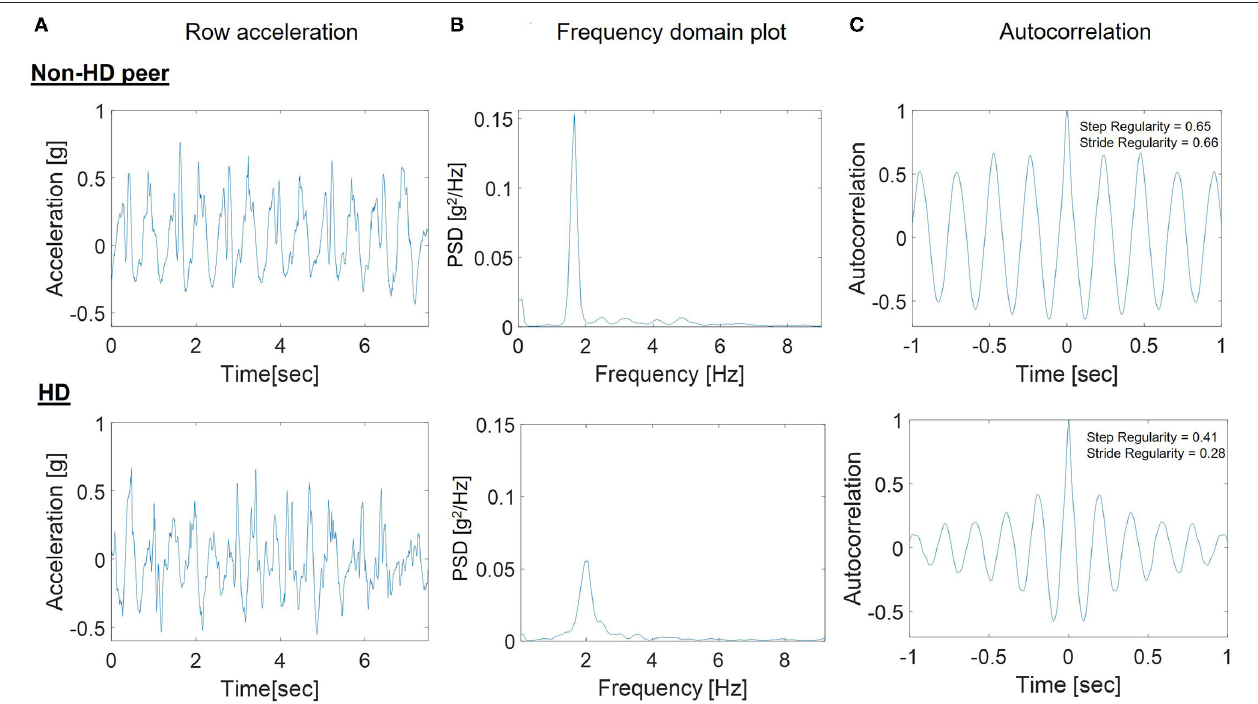
FIGURE 2 | Example steps in the processing of the 7-day accelerometer data for a participant with HD and a non-HD peer. (A) Raw SVM acceleration signal in one bout of walking; (B) Frequency domain plot used to determine the peak in the frequency domain for a bout of walking; (C) Autocorrelation plot used to determine stride regularity in the bout. The peak in the frequency domain (B) was much lower in the HD participant [ p (f) = 0.06] than in the non-HD peer [ p (f) = 1.67] and the autocorrelation plots (C) show that the step and stride regularity was significantly lower in the HD participants compared to non-HD